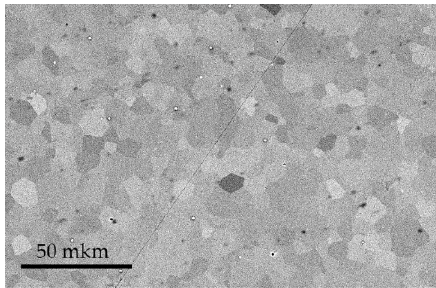
Figure 5. BSE image of Er (0.5 mol.%):Y 2 O 3 ceramics providing the orientation contrast of grains.